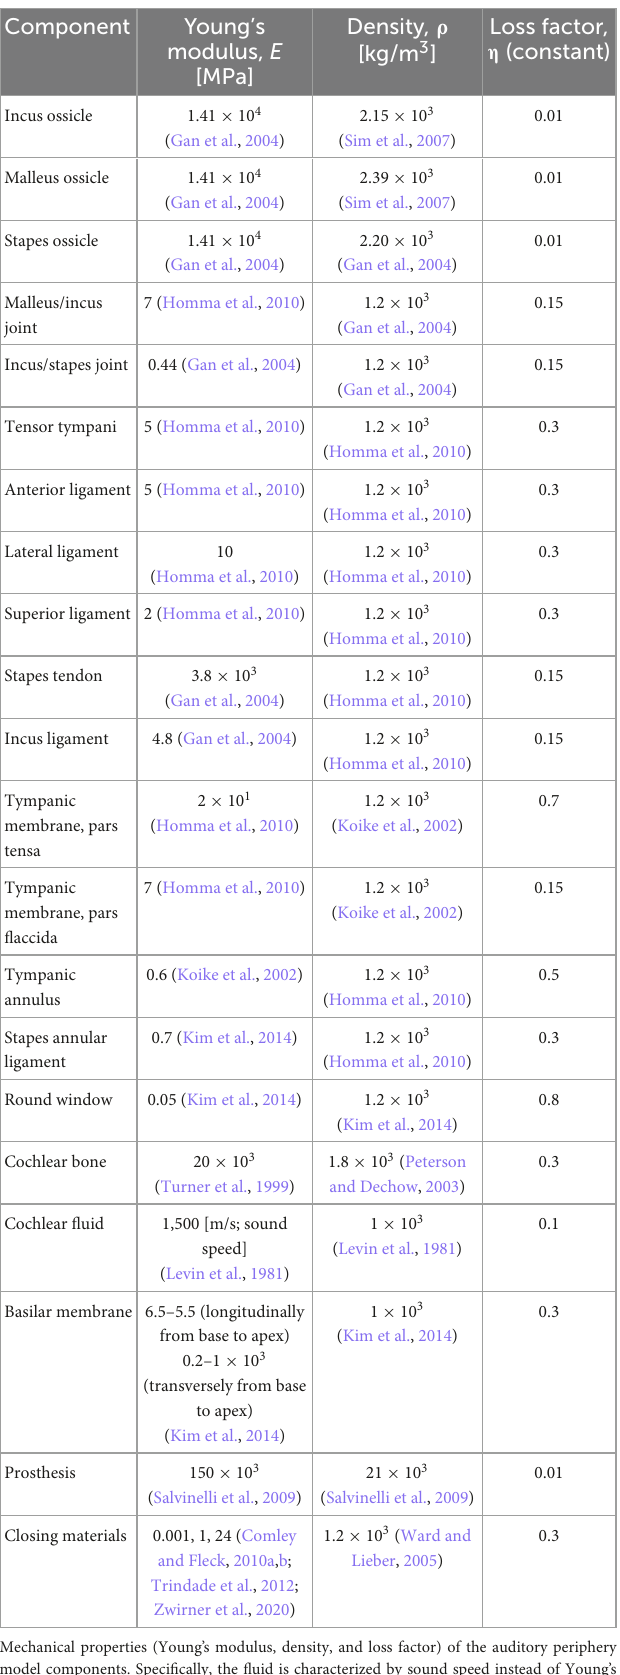
TABLE 3 Properties of 3D finite-element auditory periphery